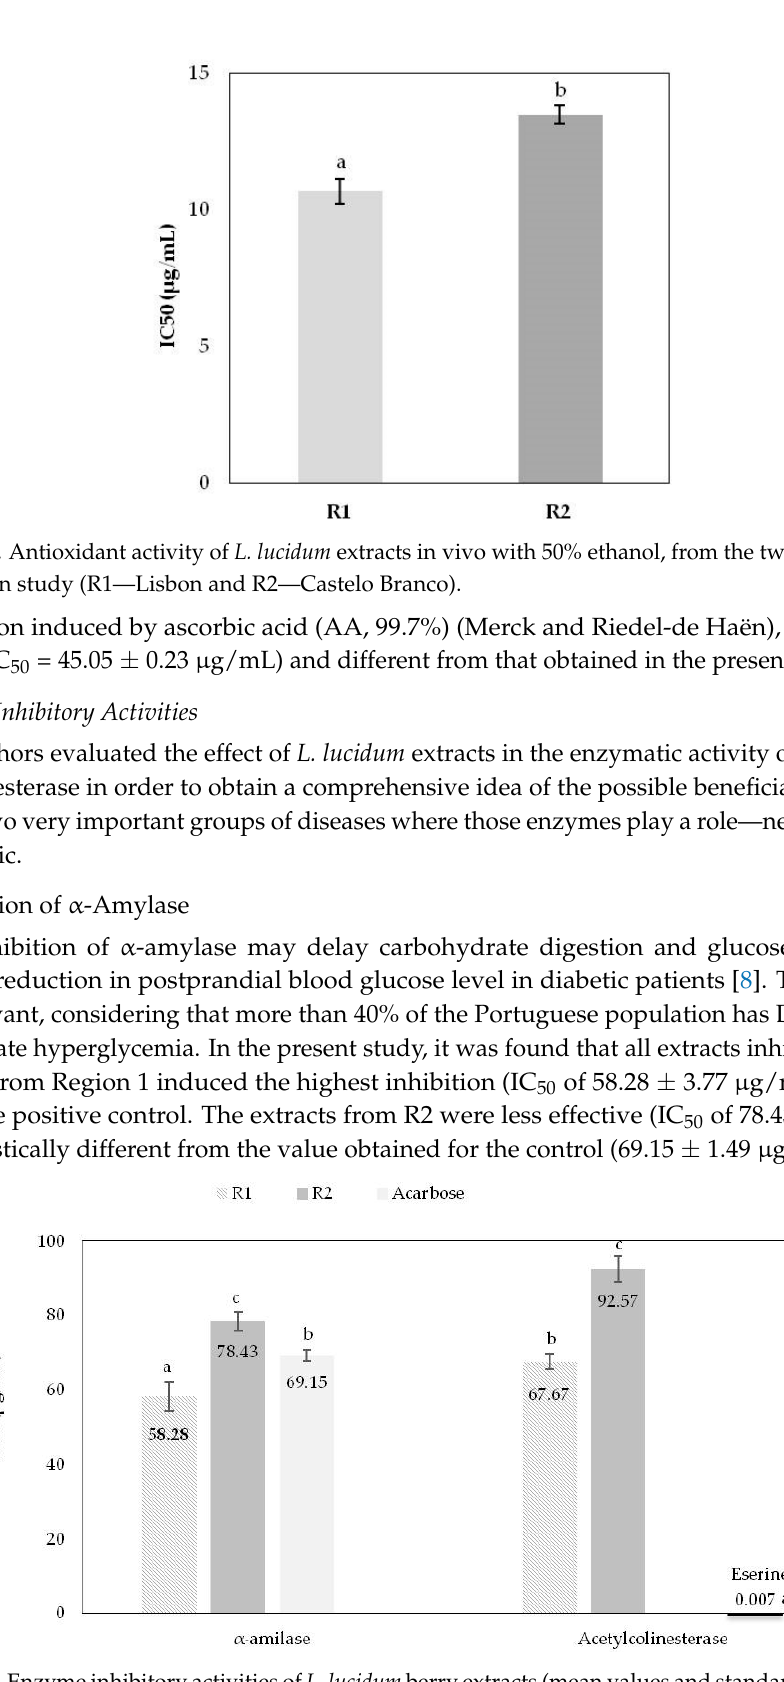
Figure 3. Enzyme inhibitory activities of L. lucidum berry extracts (mean values and standard deviations) from the two Portuguese regions in study (R1—Lisbon and R2—Castelo Branco). Mean ± SD. Different small letter (a–c) superscripts on the same column are significantly different ( p <